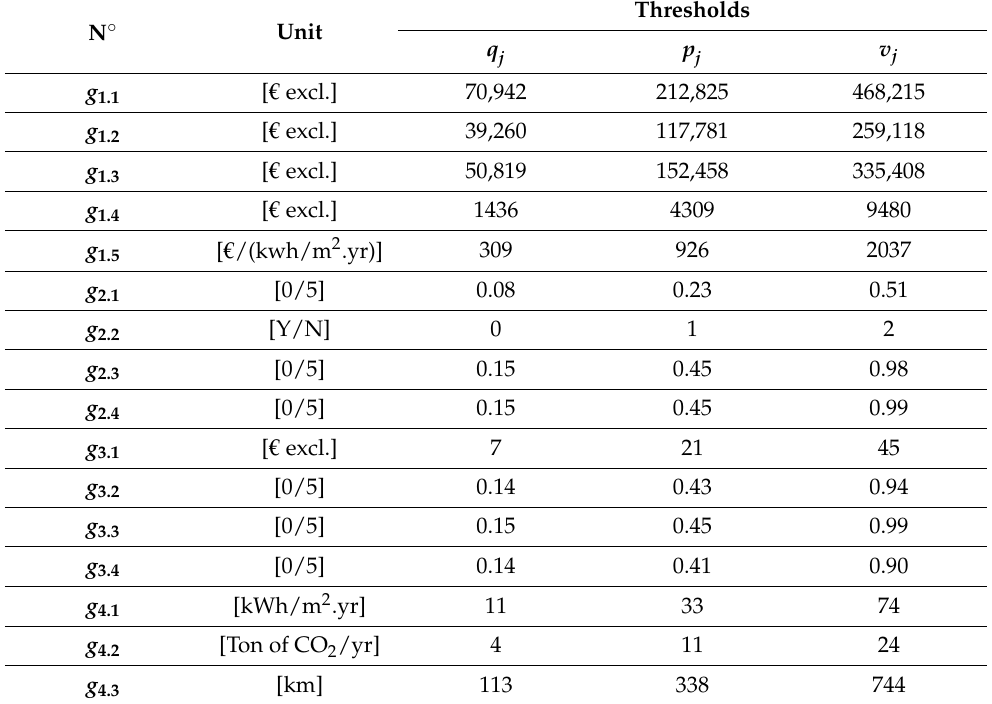
Table 12. Definition of